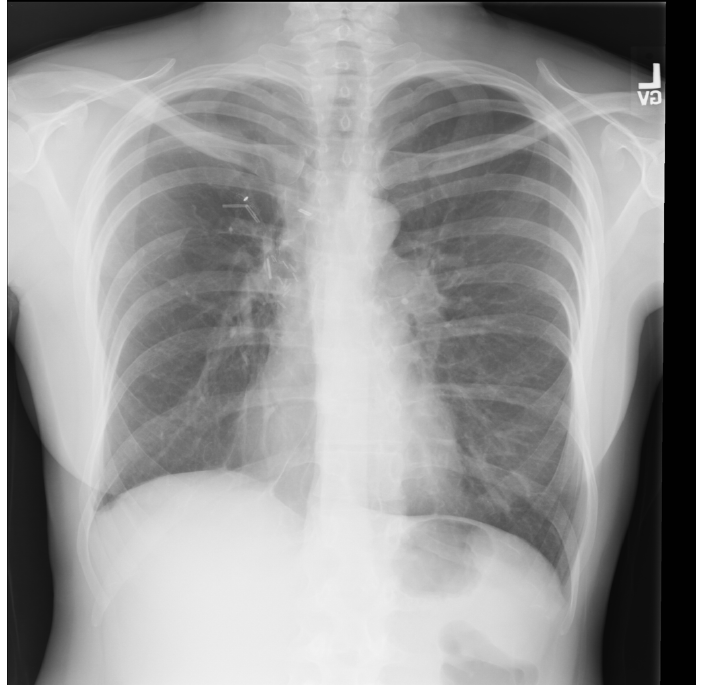
Figure 11. Normal sample: X-ray Image dataset. For balance purposes, the X-ray Image dataset is divided into a training set and a validation (or testing) set at a ratio of 957:168. As shown in Table 2, the training set contains 105 CXR images of COVID-19 positive patients, 426 healthy CXR images, and 426 non-COVID-19 CXR pneumonia images, while the testing set contains 20 CXR images of COVID-19-positive patients, 74 healthy CXR images, and 74 CXR images of non-COVID-19 pneumonia